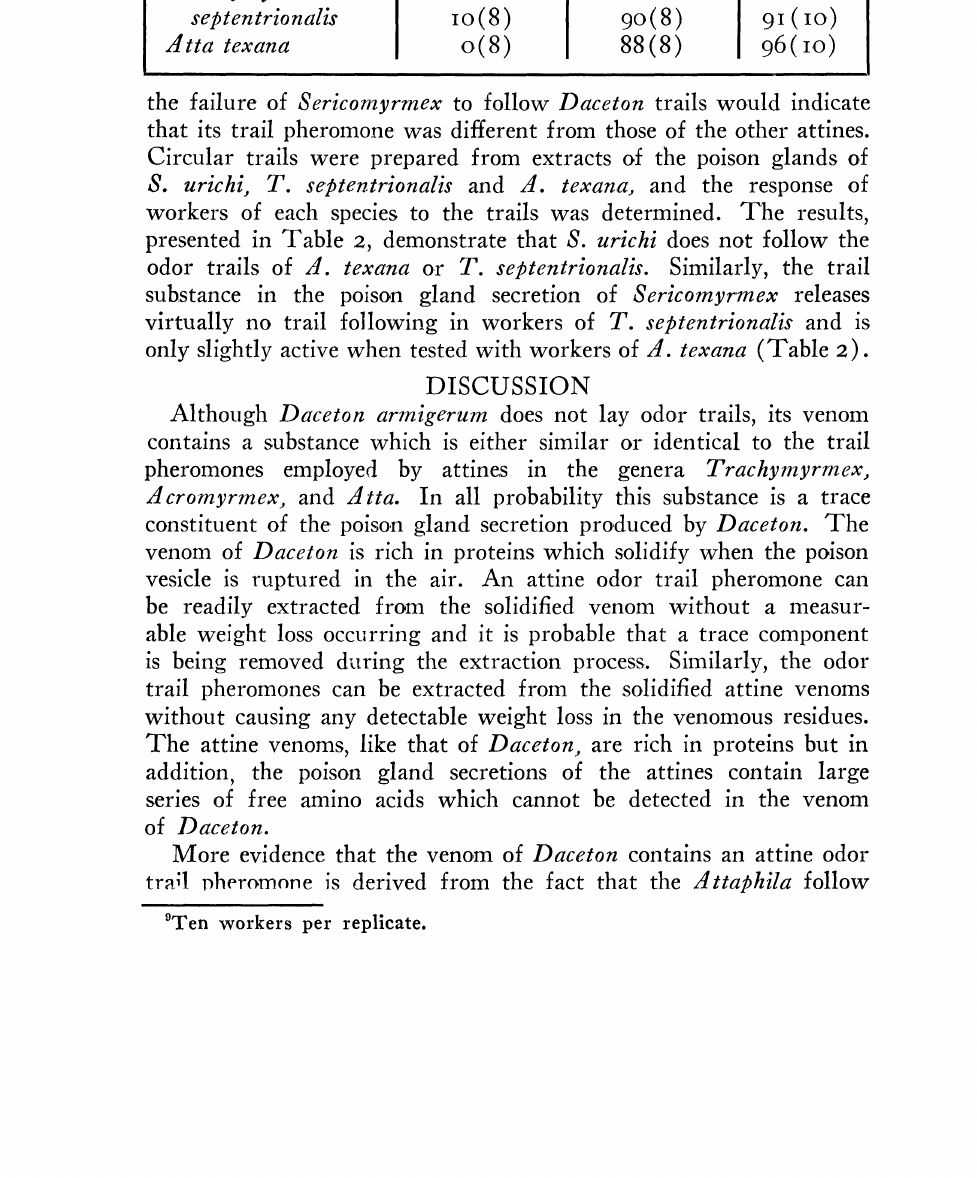
Table 2. Numbers of Sericomyrmex, Trachy.myrmex, and A tta workers responding to the poison gland secretion in the artificial test. Number of replications in parentheses